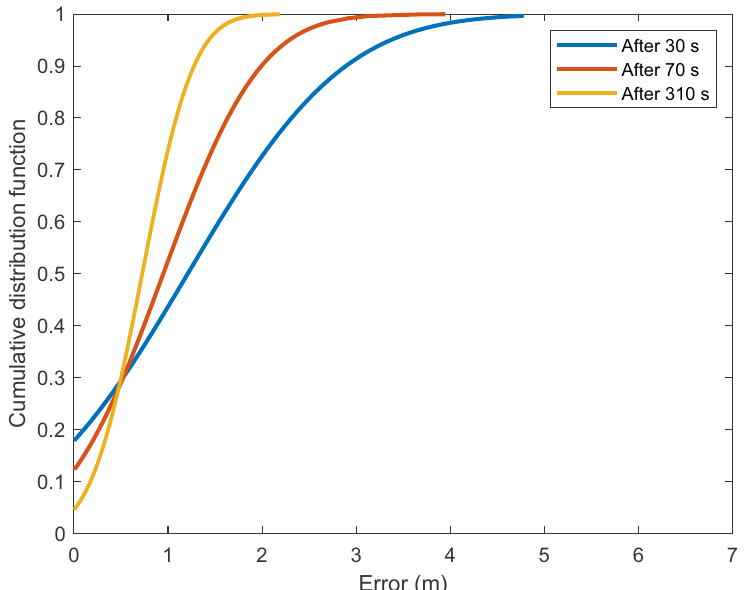
Figure 7. The cumulative distribution functions for the positioning errors in determining the positions by the PSO method after 30, 70 and 310 s of